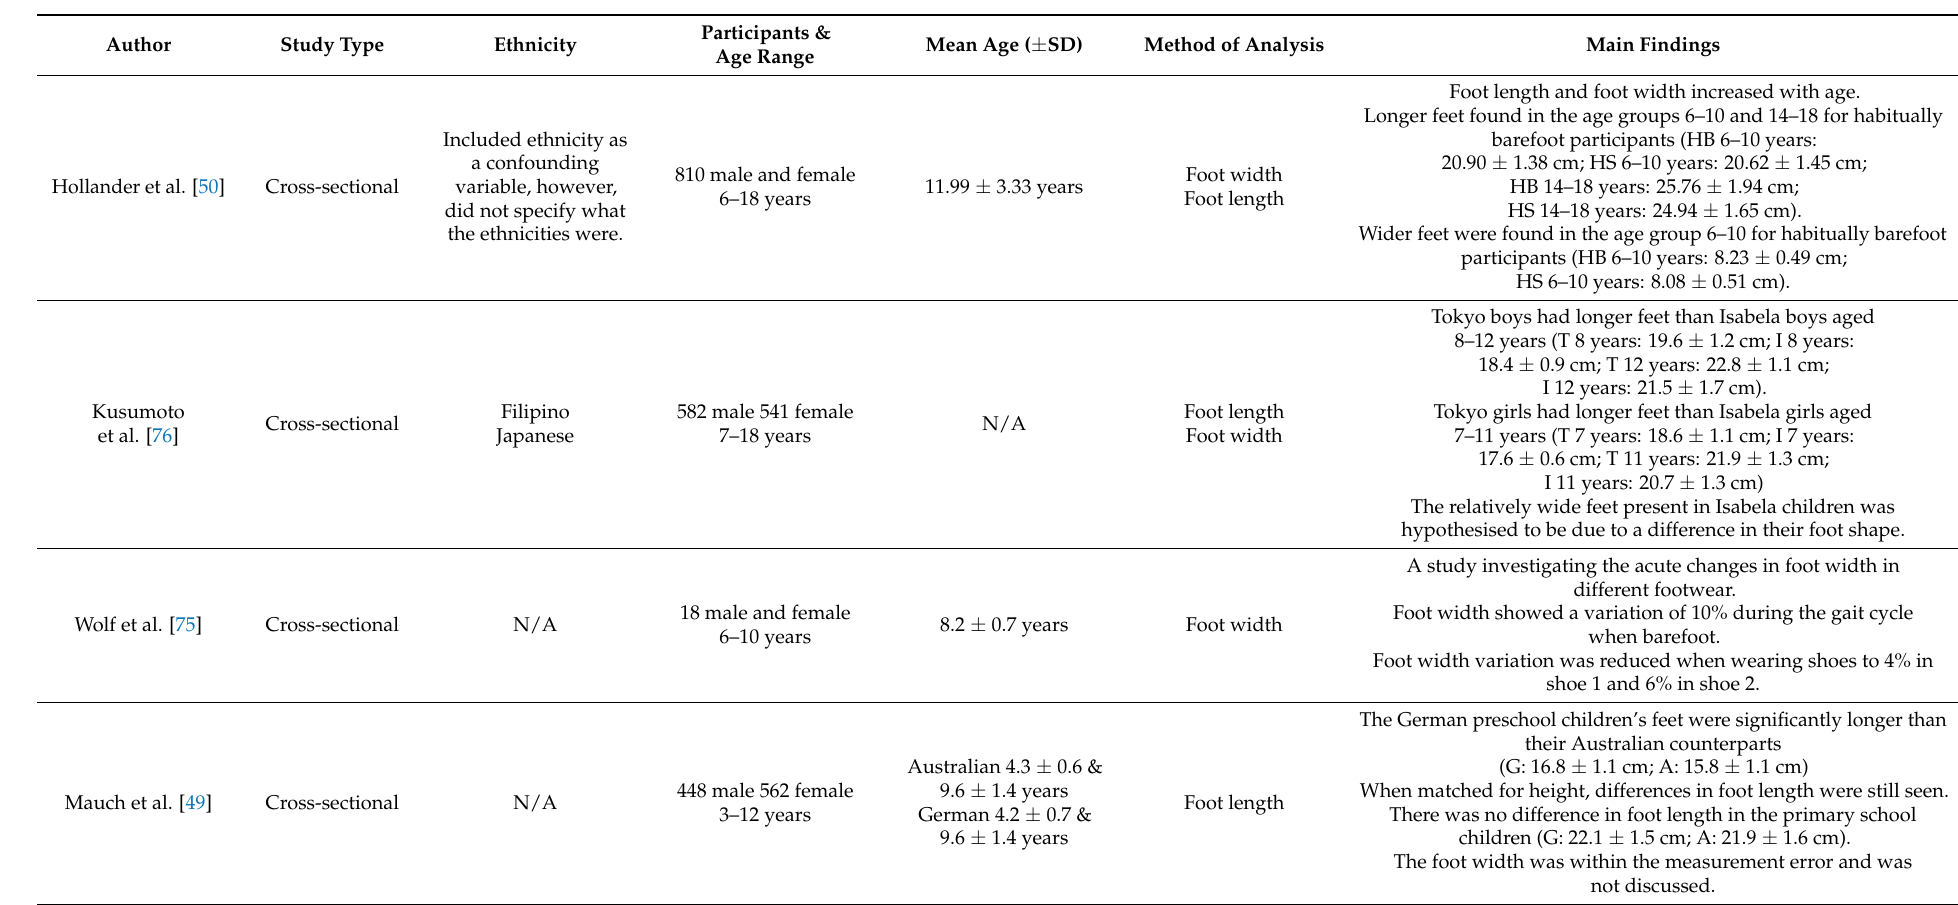
Table 4. A summary of the studies examined relating to footwear habits and foot length and